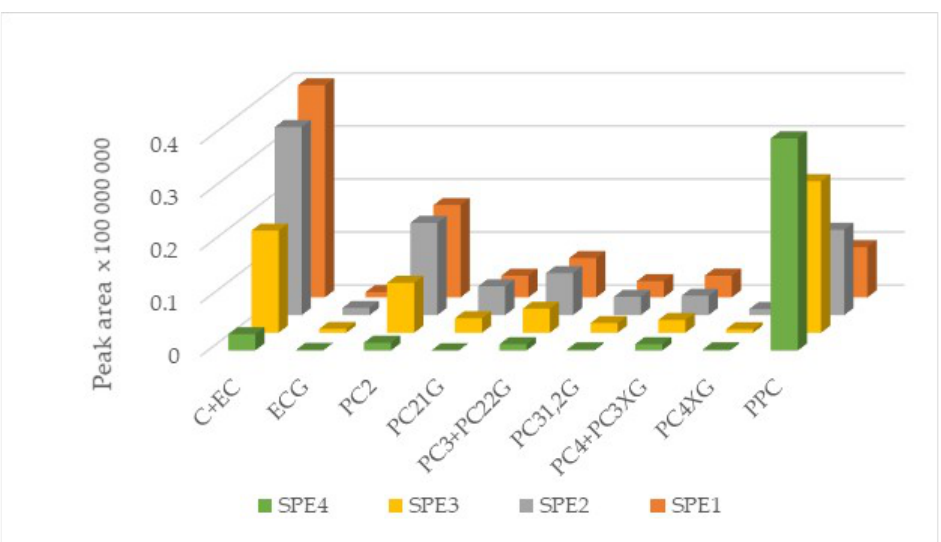
Figure 6. Areas of the peaks (acquired by NP–HPLC-PAD at 280 nm) corresponding to monomeric nongalloylated (catechin and epicatechin, C + EC) and galloylated (epicatechin gallate, ECG) catechins to tetrameric multigalloylated (PC 4 XG) and polymeric procyanidins (PPCs) from the four SPE batches of the GSE ultrafiltrate.